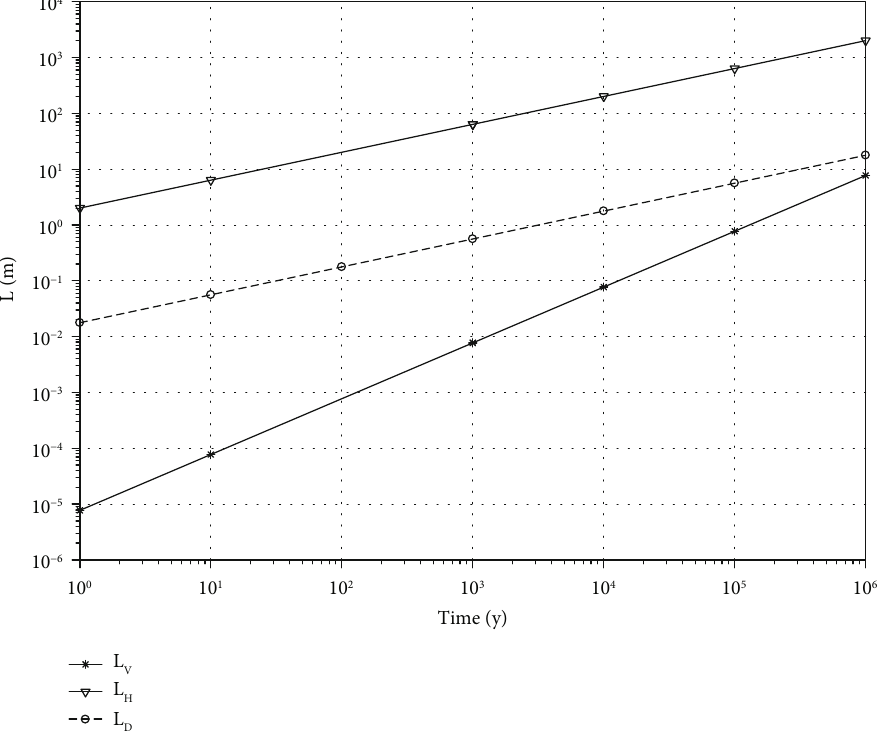
Figure 1: Length scales versus time for heat conduction ( L